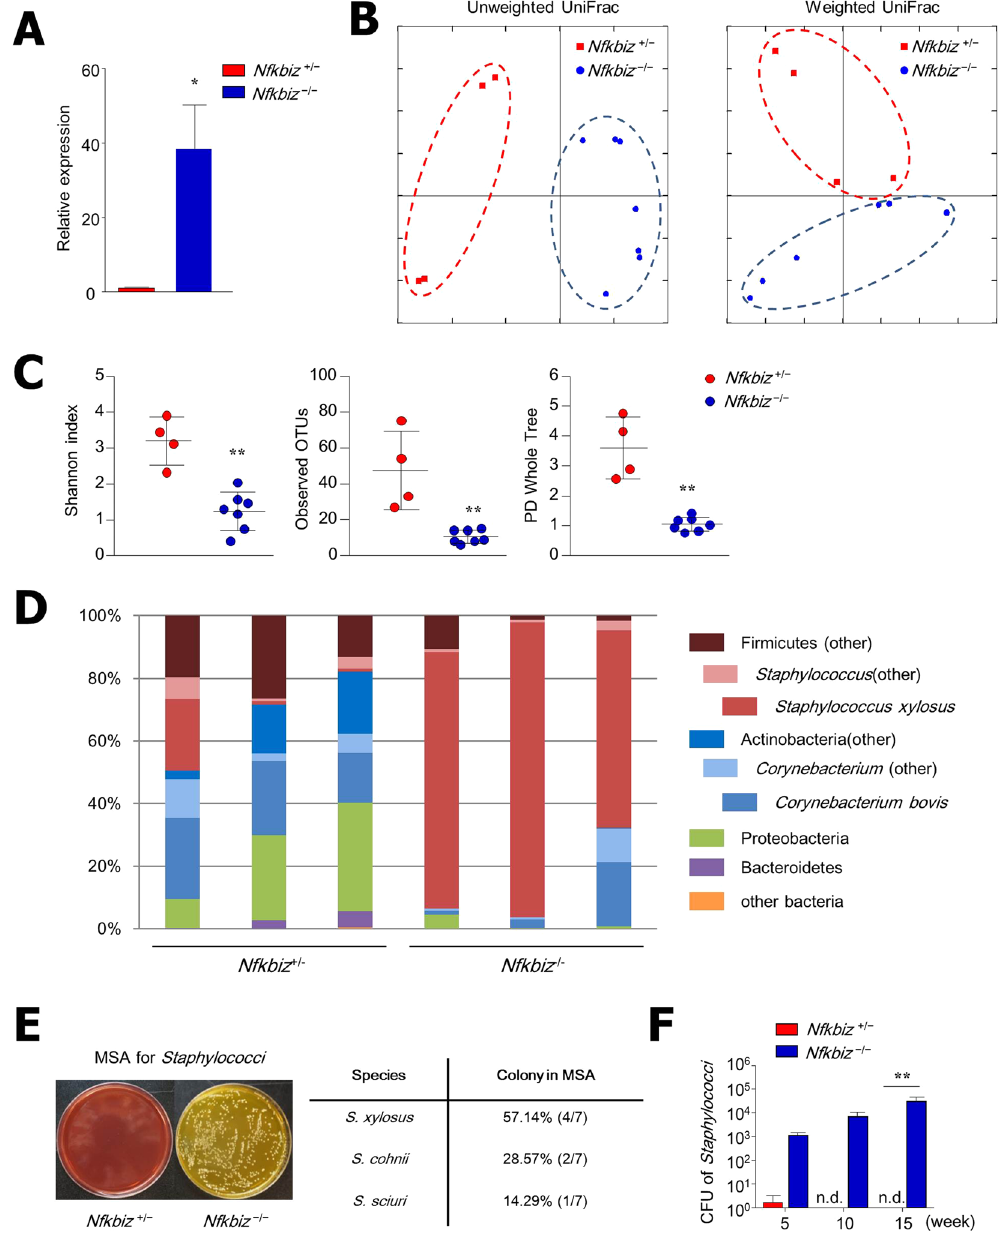
Figure 3. Increased bacterial burden and decreased bacterial diversity in skin of Nfkbiz − / − mice. ( A ) Relative expression of 16 s rDNA universal bacteria in skin of Nfkbiz + / − and Nfkbiz − / − mice. ( B ) Principal coordinate analysis of unweighted and weighted UniFrac distances between samples from skin of Nfkbiz + / − and Nfkbiz − / − mice. ( C ) Shannon index, observed operational taxonomic units (OTUs), and phylogenetic diversity (PD) whole tree of Nfkbiz + / − and Nfkbiz − / − mice. ( D ) Composition of skin bacterial communities in Nfkbiz + / − and Nfkbiz − / − mice at phylum level ( > 1% of total 16S rRNA sequences) with additional speciation of Corynebacterium and Staphylococcus genera. Each bar represents relative abundance in one mouse. Results are representative of two experiments (n = 4–6 per group). ( E and F ) Quantification of Staphylococcus species from skin swabs of Nfkbiz + / − and Nfkbiz − / − mice performed using mannitol salt agar (MSA). Data are mean ± s.e.m. ( A and F ). * p < 0.05, ** p < 0.01. n.d., not